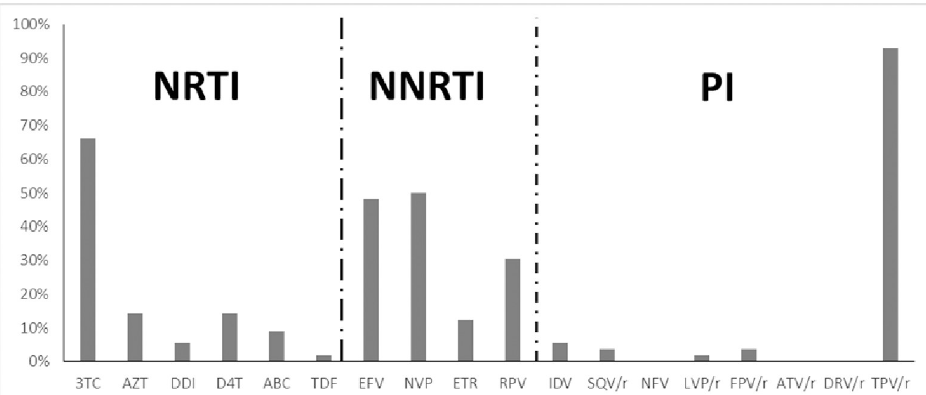
Fig 2. Resistance to different ARV drugs in children with virological failure. The proportion of resistance to individual ARV drug is shown on the figure. Different ARV classes are indicated: NRTI, nucleoside reverse transcriptase inhibitors; NNRTI, non-nucleoside reverse transcriptase inhibitors; PI, protease inhibitors. ARV drugs are shown on the X-axis and the percentage of detection on the Y-axis. 3TC/FTC, lamivudine/emtricitadine; ZDV/ AZT, zidovudine; DDI, didanosine; D4T, stavudine; ABC, abacavir; TDF, tenofovir; EFV, efavirenz; NVP, nevirapine; ETR, etravirine; RPV, rilpivirine; IDV, indinavir; SQV, saquinavir; NFV, nelfinavir; LPV, lopinavir; FPV, fosamprenavir; ATV, atazanavir; DRV, darunavir; TPV, tipranavir; r, ritonavir.